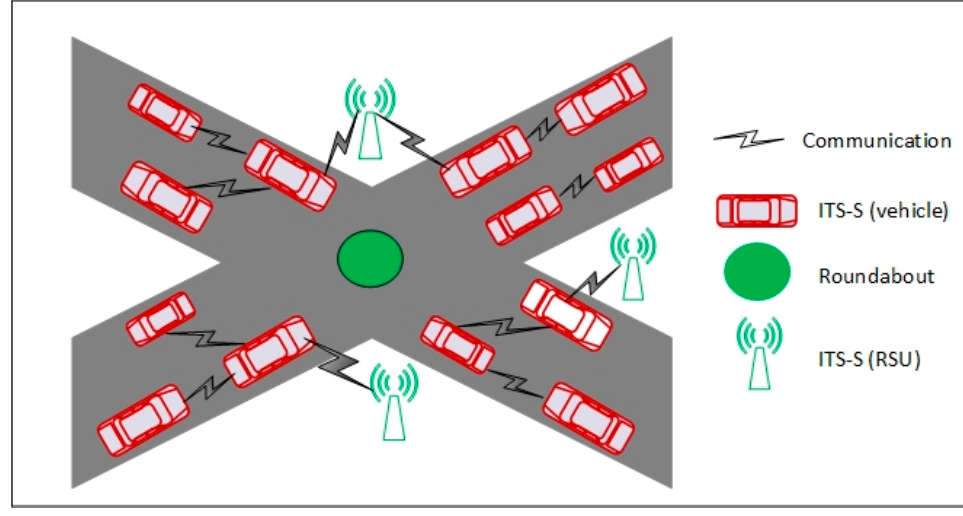
Figure 2. Intelligent transport system scenario.